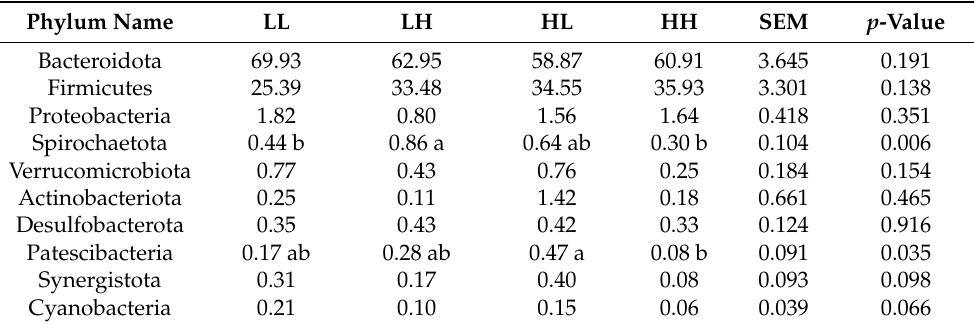
Table 4. Effect of the energy provision strategy on the rumen bacterial composition of Hu sheep at the level of phylum (>0.10%).